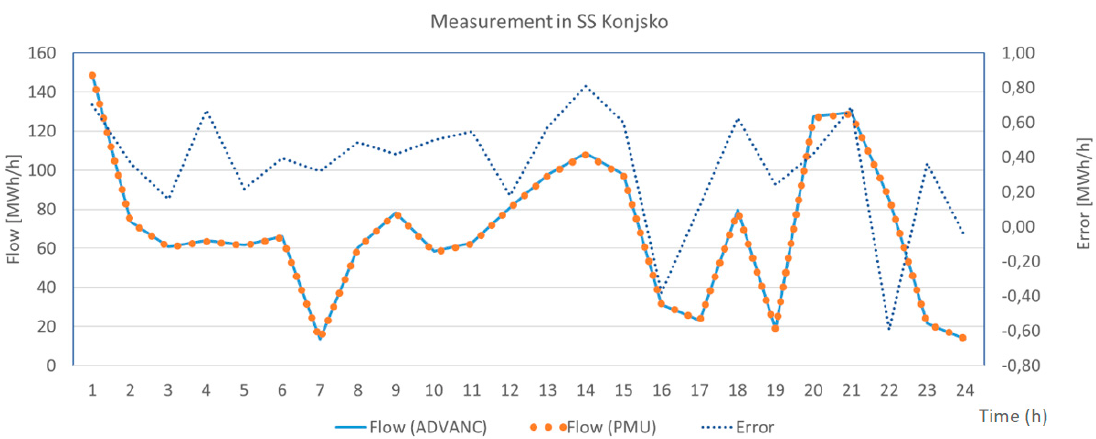
Figure 14. Comparison of power flow measurements and difference between ADVANC and PMU measurements in SS Velebit and SS Konjsko.